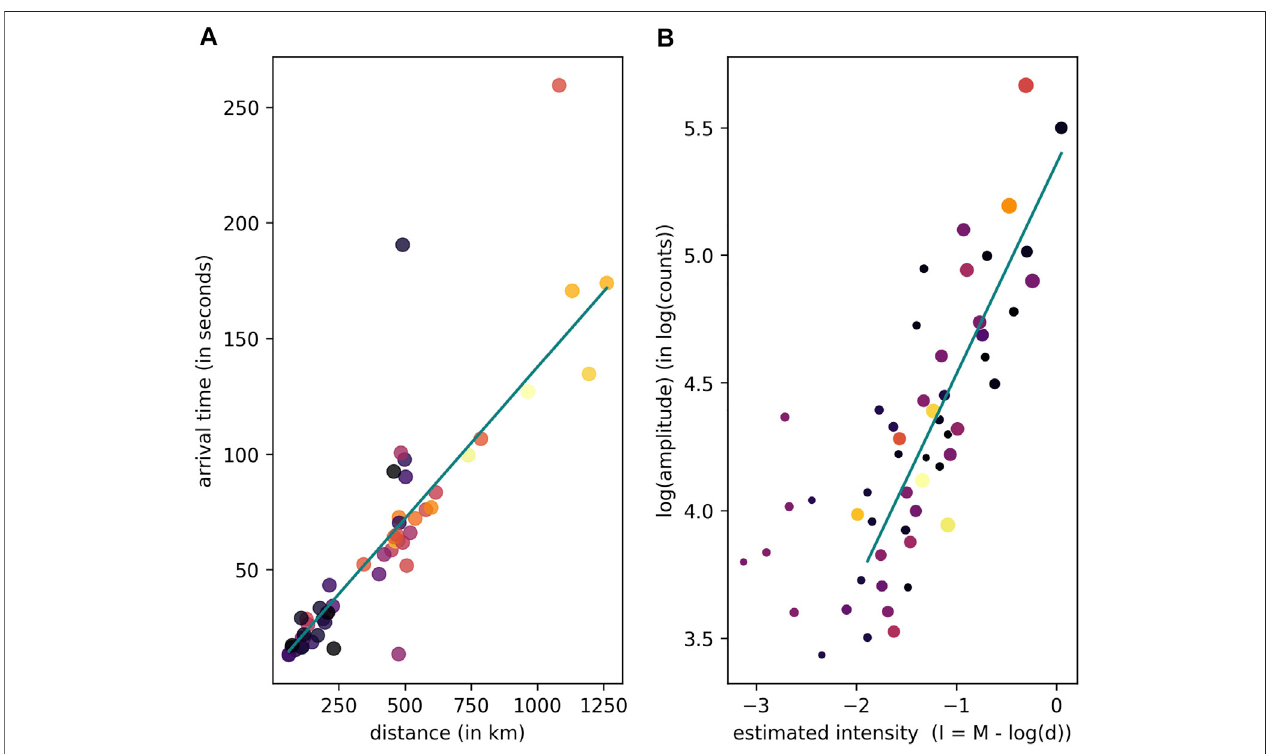
FIGURE 7 | Arrival time and amplitude estimate of tectonic earthquake signals recorded at Stromboli.